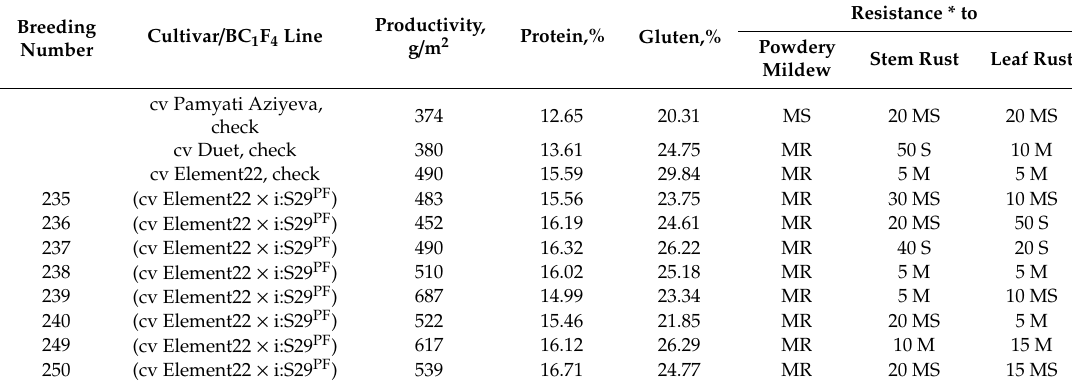
Figure A3. Electrophoregram of PCR products obtained using primers for the microsatellite locus Xgwm0312 (chromosome 2A) on DNA of the isogenic donor line i:S29 Pp-D1Pp3 PF (P 1 , lane 1), cv Aina DNA (P 2 , lane 2), and corresponding F 2 heterozygous / homozygous progenies. Table A1. The results of the assessment of the purple-grained wheat lines (BC 1 F 4 ) from “BN plots” in the experimental field at the Omsk State Agrarian University, 2019.